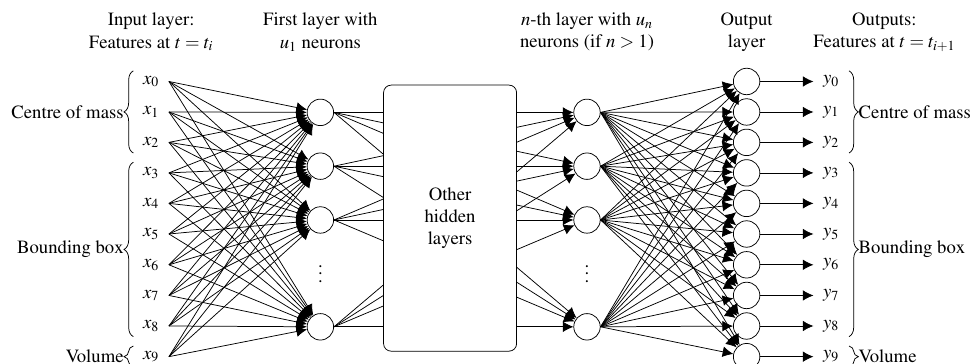
Figure 8. Schematic representation of the multi-layer perceptron network topology used, containing n hidden layers with u i neurons